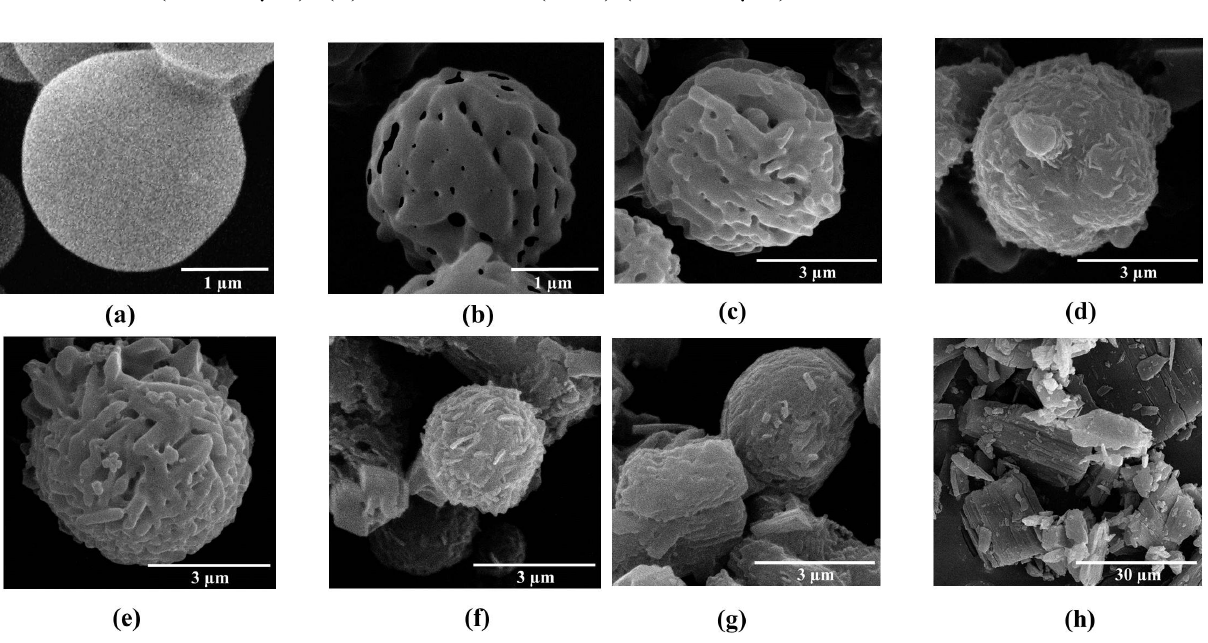
Figure 1. The scanning electron microscope (SEM) images of ( a ) spray dried mannitol (bar = 1 μ m); ( b ) porous mannitol (bar = 1 μ m); ( c – g ) LEV-proliposome formulation No. 1 to No. 5 (bar = 3 μ m); ( h ) Levofloxacin (LEV) (bar = 30 μ